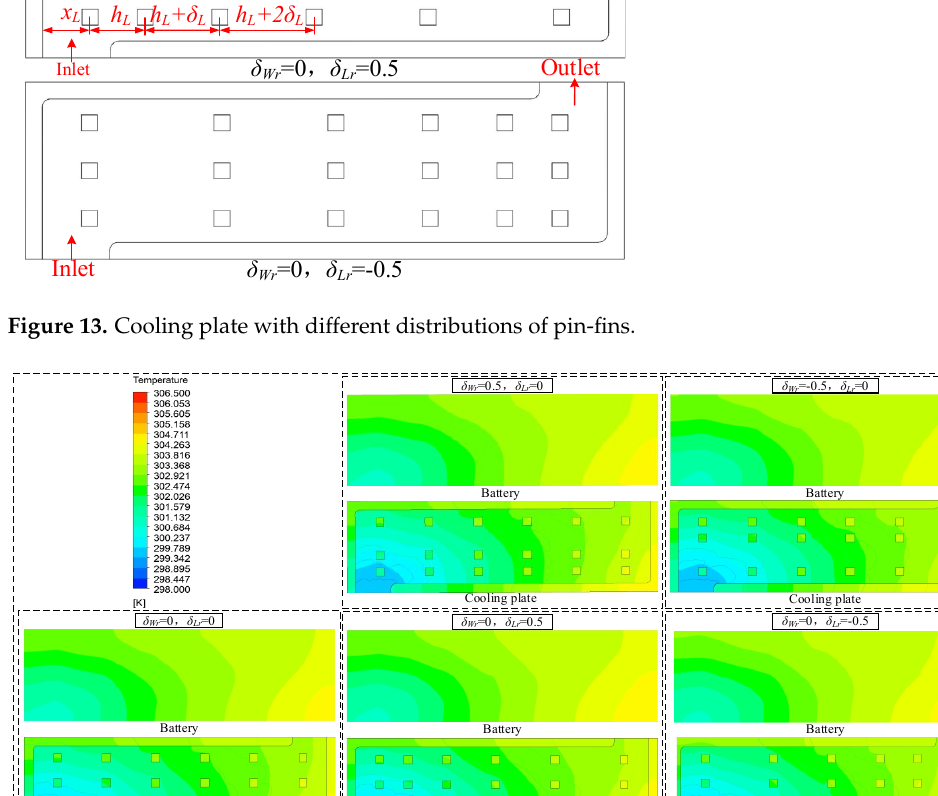
Table 7. Effect of various pin-fin distributions. Pin-Fin Distribution